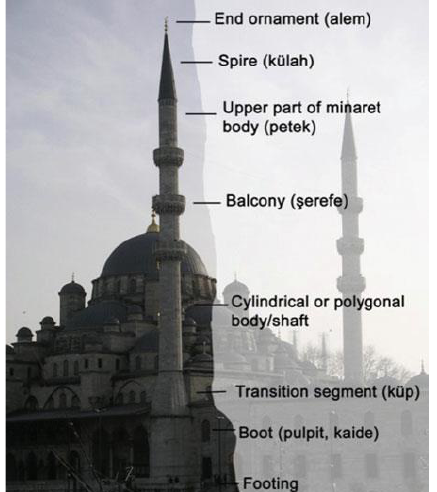
Figure 1. Elements of a minaret (Pellegrinelli et al., 2014)